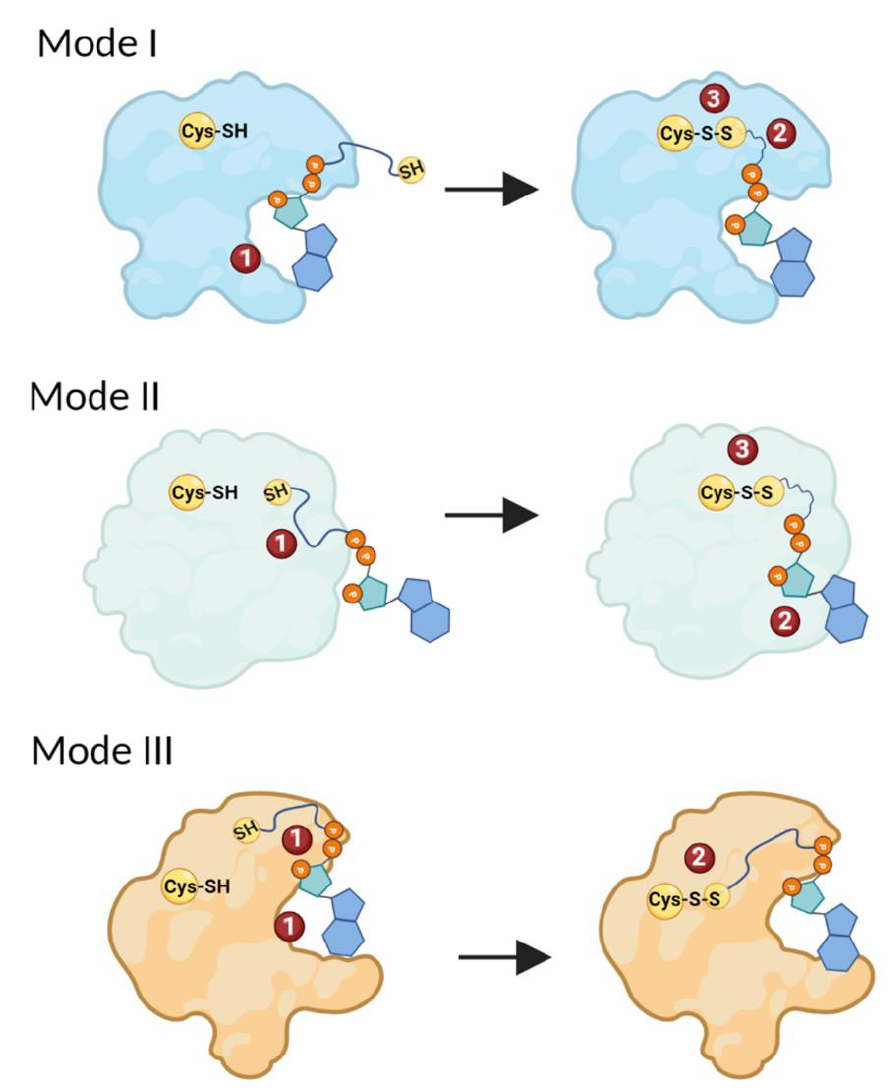
Figure 5. Different modes of CoA binding to proteins. In Mode I, the ADP moiety of CoA binds to a protein first. This primes the stabilization of the pantetheine tail, followed by the formation of a mixed-disulfide bond. In Mode II, protein CoAlation is initiated by the stabilization of the pantetheine tail of CoA, which primes the binding and stabilization of the ADP moiety of CoA and the formation of a mixed disulfide. In Mode III, both the ADP moiety and the pantetheine tail simultaneously bind the protein, followed by the formation of a mixed-disulfide bond. The different steps of CoAlation are indicated with numbers. The figure was generated using Biorender.